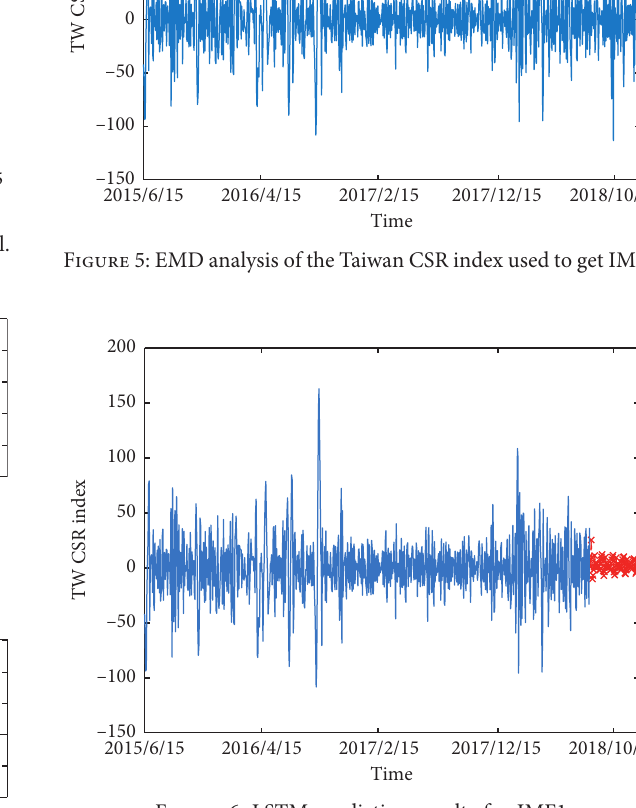
Figure 6: LSTM prediction results for